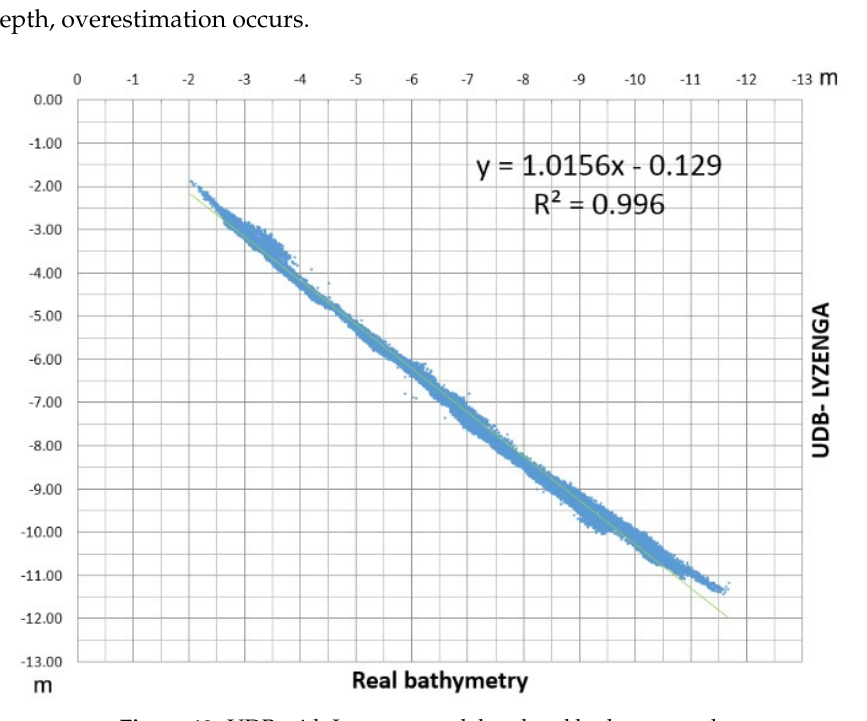
Figure 12. UDB with Lyzenga model and real bathymetry plot.